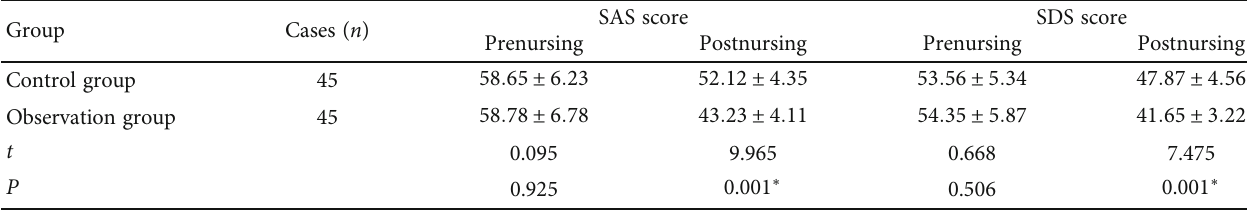
Table 3: Comparison of adverse emotions before and after care for patients in 2 groups ( (cid:1) x ± s ).